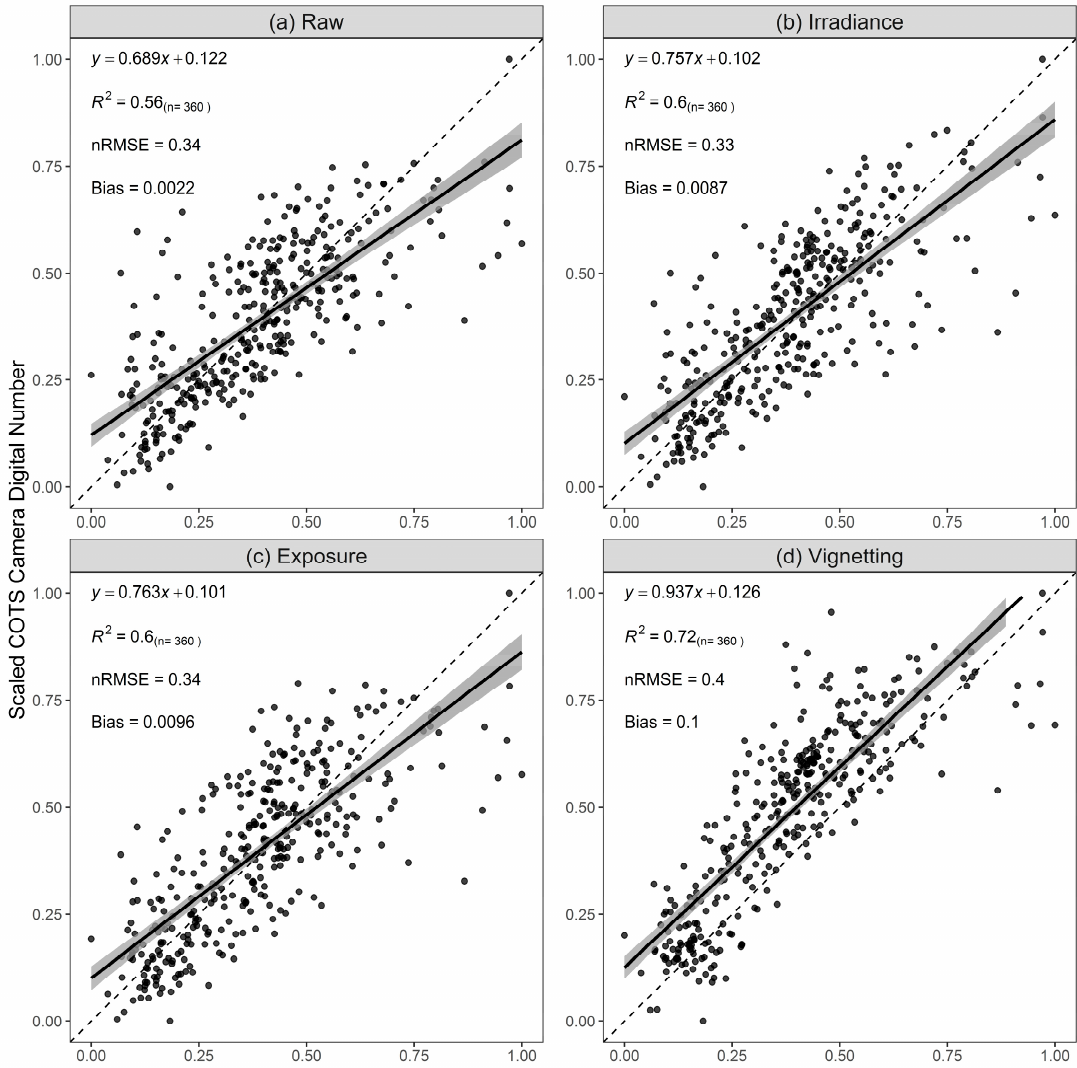
Figure 8. Assessment of the cumulative influence of correction steps on the precision of scaled mean plot measurements in the NIR band. Scaled reflectance for ( a ) Raw, ( b ) Irradiance, ( c ) Exposure and ( d ) Vignetting corrected images are compared to scaled COTS camera convolved Tec5 measurements of mean plot reflectance. The dashed line represents the 1:1 line.